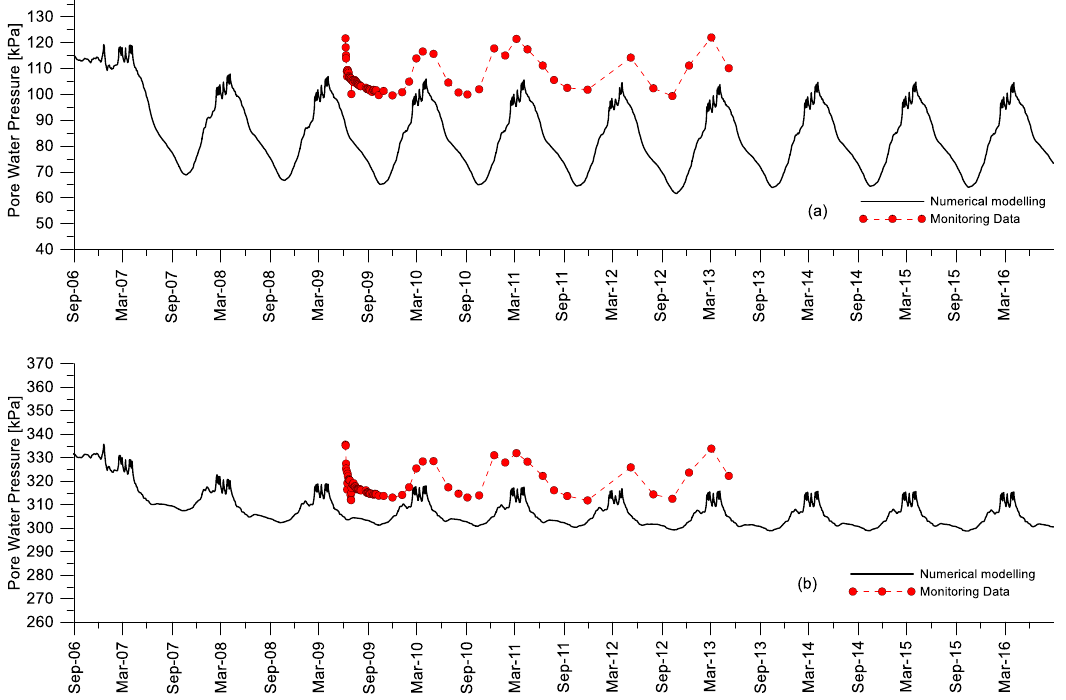
Figure 12. Pore water pressures monitored through the piezometers down P7 (Figure 1) and corresponding numerical predictions for point V ( a ) and for point W ( b ) in Figure 11.